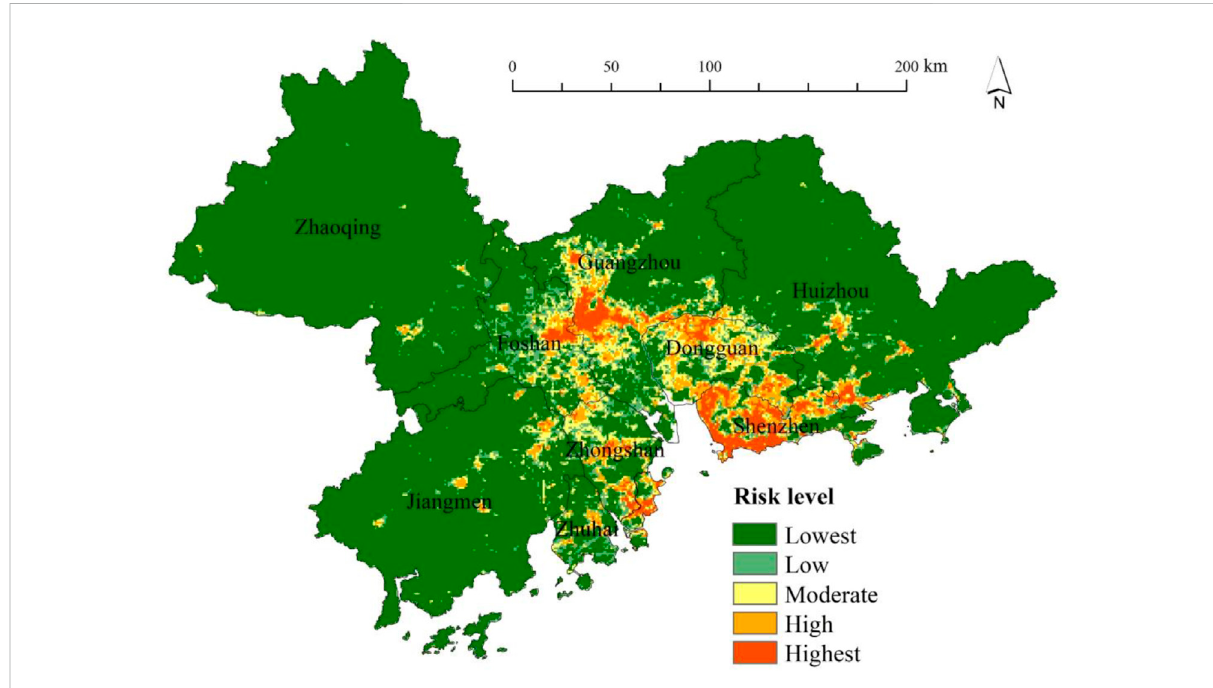
FIGURE 5 Spatial distribution of fl ood risk in the PRD under the original